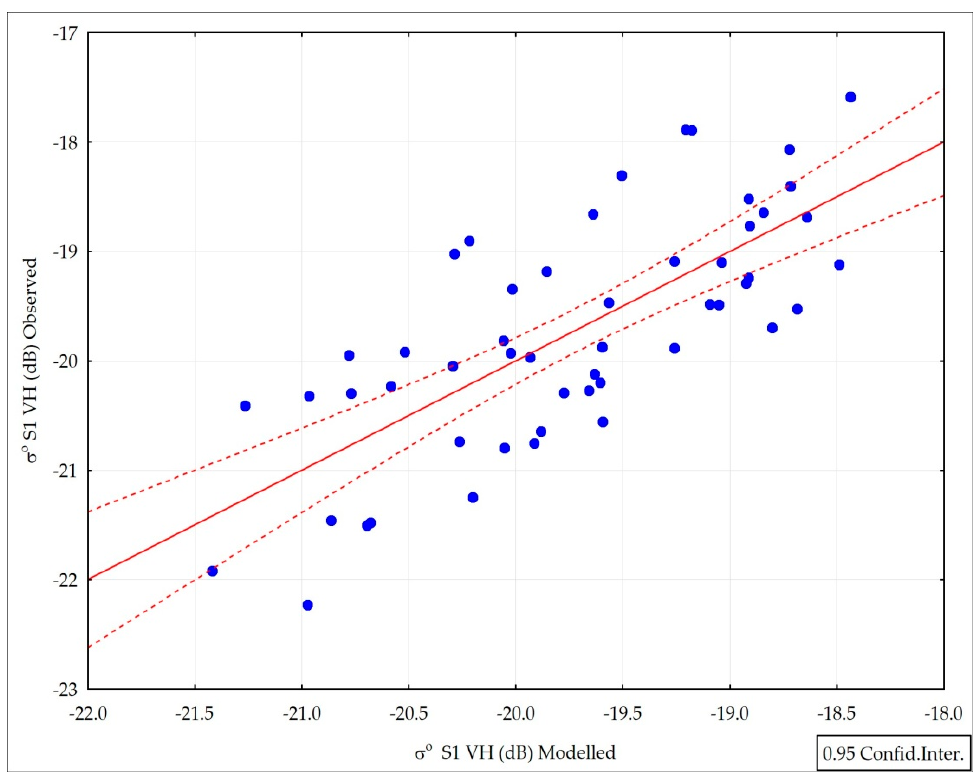
Figure 10. Relationship between σ ° VH observed and predicted by applying Equation (3). With fixed low soil moisture values, the range of backscatter variance depended on LAI and could increase up to 3.2 dB. When LAI is on a fixed level, the variance of backscatter caused by SM gets up to 2.4 dB, (Figure 11). Contribution of LAI to backscatter VH was higher when SM values were low. High difference of σ ° VH between two points covered by vegetation does not mean that the soil moisture is really different. In the model (3) σ ° VH > − 19 dB represents a high value of LAI for SM of about 30%–40%. The same values of σ ° VH, i.e., > − 19 dB in the model (2) occurred for high SM (>70%) independently of LAI (Figures 9 and 11).